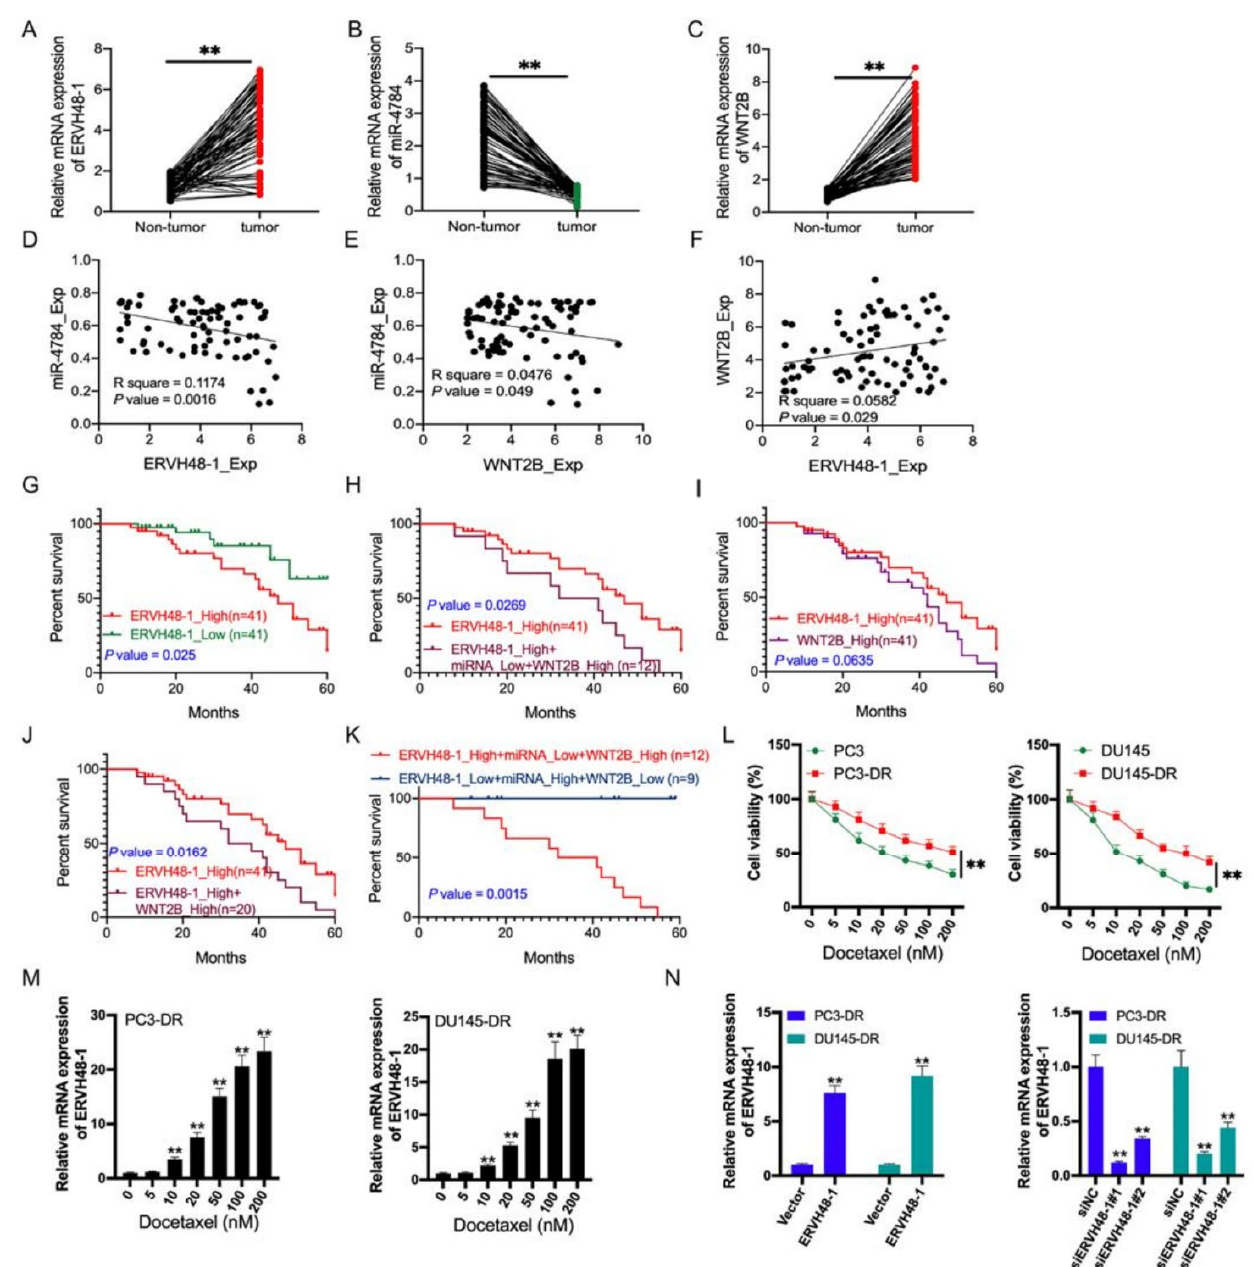
Figure 4. High ERVH48 ‐ 1 expression was detected in PCa tumor tissue and Dox ‐ resistant PCa cells and was connected with poor survival. RT ‐ PCR analysis of ERVH48 ‐ 1 expression ( A ); miR ‐ 4784 cells and was connected with poor survival. RT-PCR analysis of ERVH48-1 expression ( A ); miR- expression ( B ); and WNT2B expression ( C ). Correlation analysis of ERVH48 ‐ 1 expression and miR ‐ 4784 expression ( B ); and WNT2B expression ( C ). Correlation analysis of ERVH48-1 expression 4784 expression ( D ); WNT2B expression and miR ‐ 4784 expression ( E ), ERVH48 ‐ 1 expression and and miR-4784 expression ( D ); WNT2B expression and miR-4784 expression ( E ), ERVH48-1 ex- pression and WNT2B expression ( F ). Survival analysis of high ERVH48-1 expression and low ERVH48-1 expression ( G ), ERVH48-1_High and ERVH48-1_High+miRNA_Low+WNT2B_High ( H ), ERVH48-1_High and WNT2B_High ( I ), ERVH48-1_High and ERVH48-1_High+WNT2B_High ( J ), ERVH48-1_High+miRNA_Low+WNT2B_High and ERVH48-1_Low+miRNA_High+WNT2B_Low ( K ). ( L ) CCK8 analysis of cell viability for PCa cell lines. ( M ) RT-PCR analysis of ERVH48-1 expression in PC3-DR and DU145-DR cells. ( N ) RT-PCR analysis of ERVH48-1 expression in the different